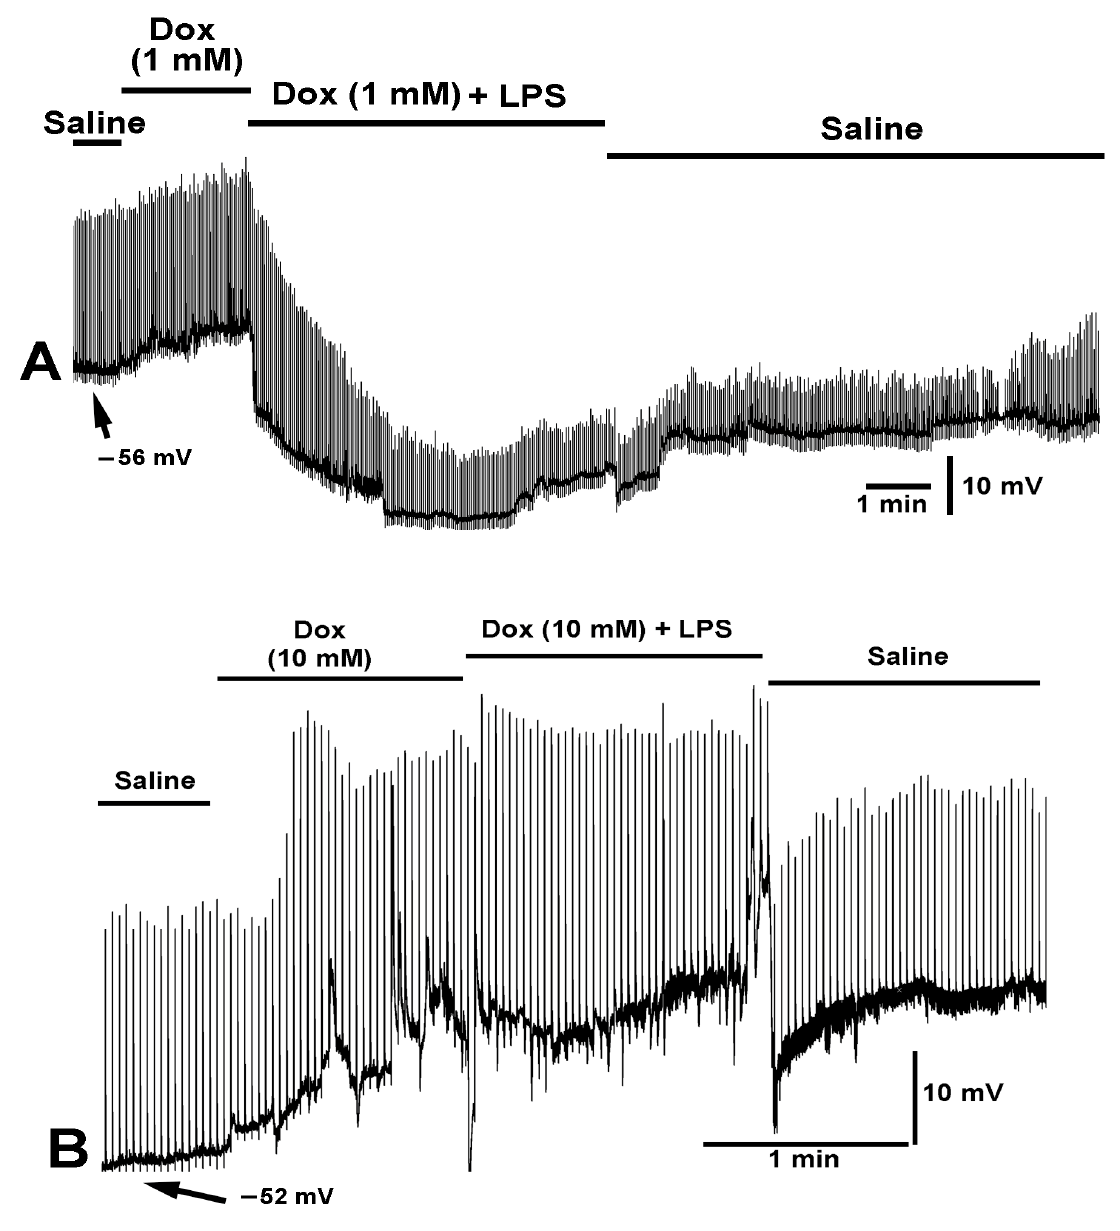
Figure 9. The effect of doxapram (1 and 10 mM) and a cocktail of doxapram (1 and 10 mM) with LPS on membrane potential and evoked EJPs. The segmental nerve was stimulated at a rate of 0.5 Hz. ( A , B ) Two different preparations are shown with varied concentrations of doxapram. ( A ) A concentration of 1 mM doxapram resulted in depolarization of the membrane and the combination of doxapram (1 mM) with the same concentration (250 µ g/mL) of LPS as used in B produced a hyperpolarization without the rapid depression in the amplitudes of the evoked EJPs. Upon exchanging the media for fresh saline, the amplitudes of the EJPs increased and the membrane potential trended towards regaining the initial value. ( B ) Doxapram at 10 mM produced a large depolarization and increased the amplitude of the evoked EJPs despite a reduced driving gradient due to the membrane being depolarized. The subsequent exchange of the media to doxapram (10 mM) and LPS (250 µ g/mL) did not maintain a hyperpolarized state and the evoked as well as mEJPs were not greatly affected by the LPS. Upon exchanging the bath to fresh saline, the evoked EJPs reduced in amplitude but a high frequency of mEJPs